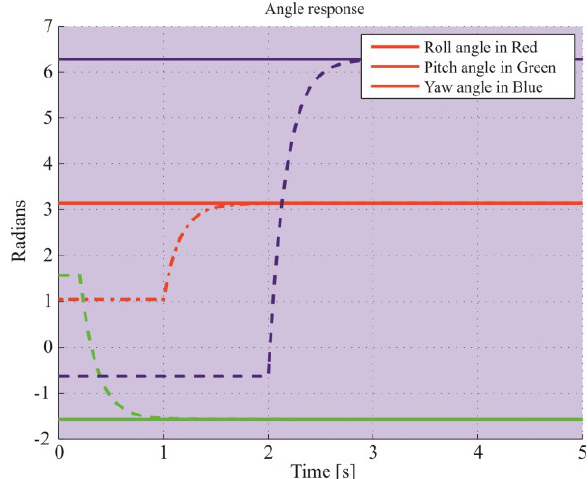
Fig. 2. Trajectory of the platform